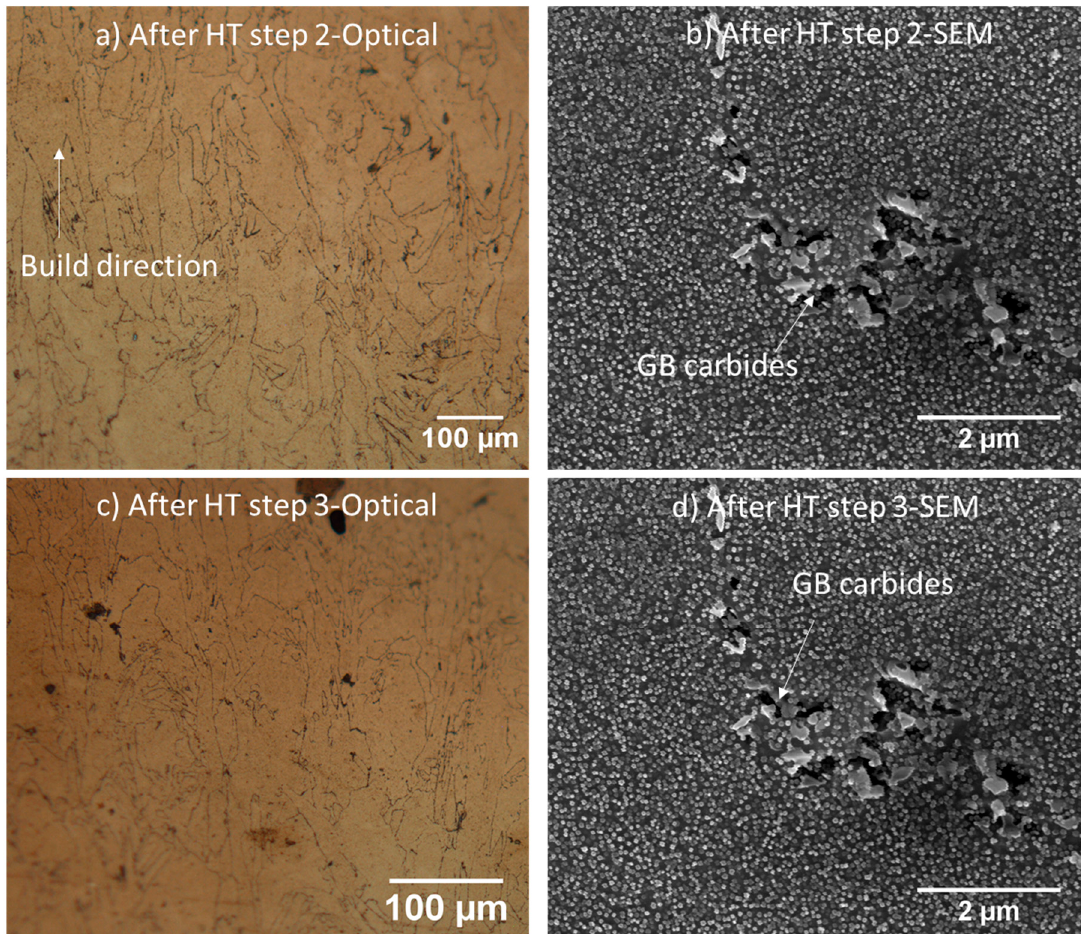
Figure 4. ( a ) Optical image of the microstructure after 2 nd heat-treatment step, ( b ) SEM image of the microstructure after 2 nd heat-treatment step, ( c ) Optical image of the microstructure after 3rd and final heat-treatment step, and ( d ) SEM image of the microstructure after 3 rd and final heat-treatment step.